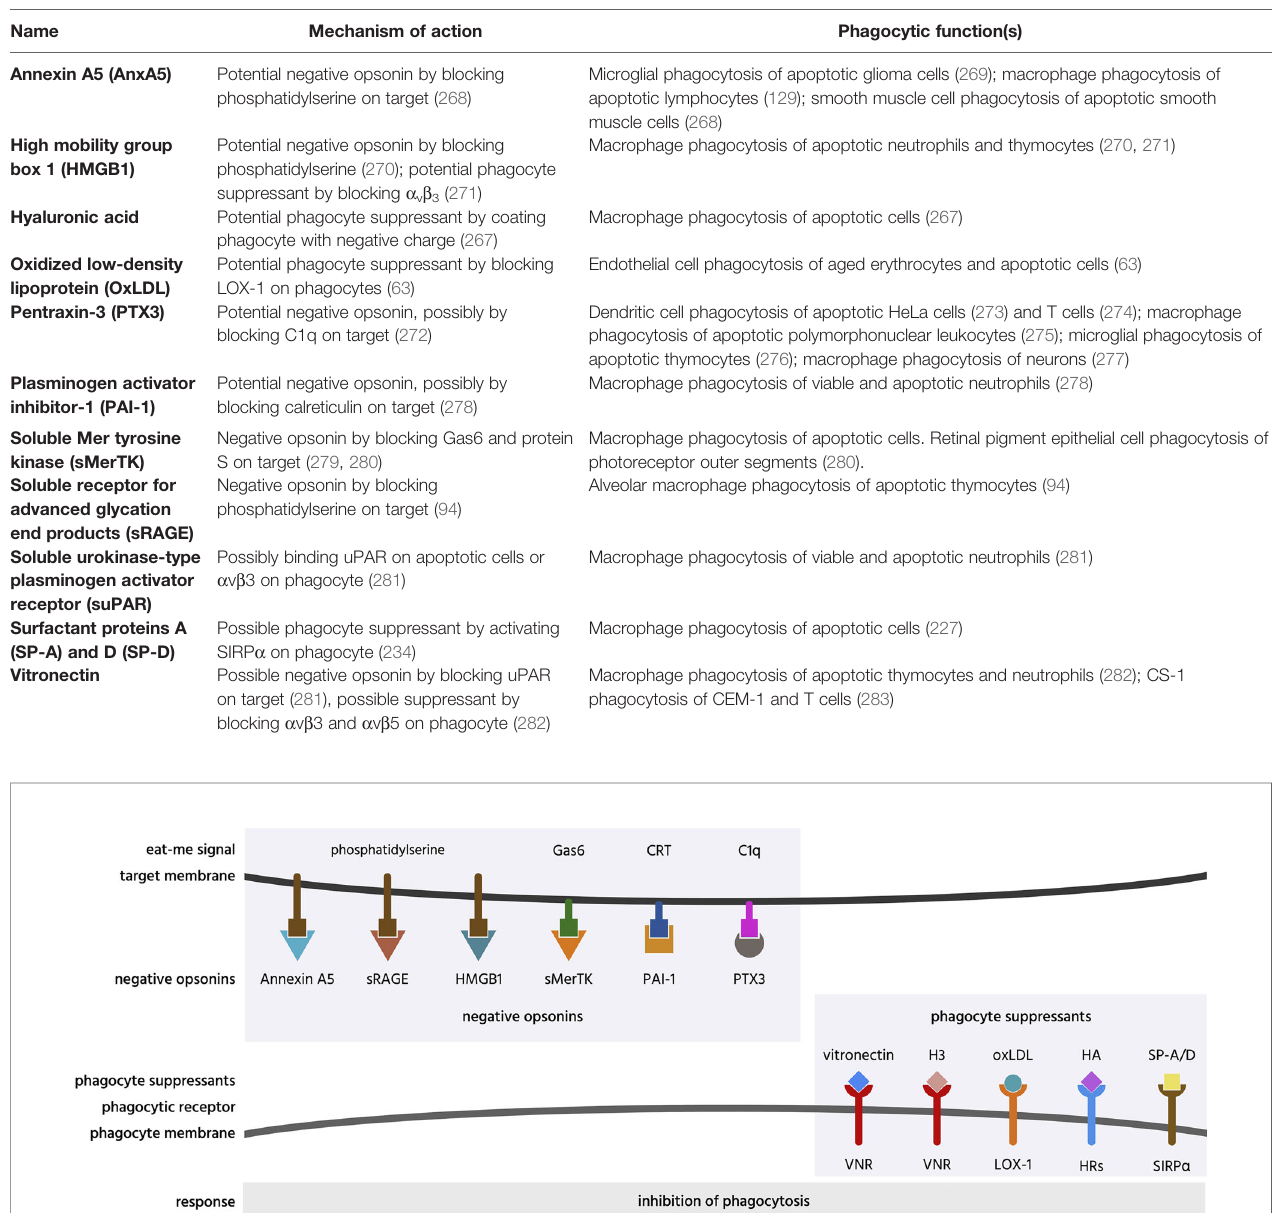
TABLE 5 | Negative opsonins and phagocyte suppressants.